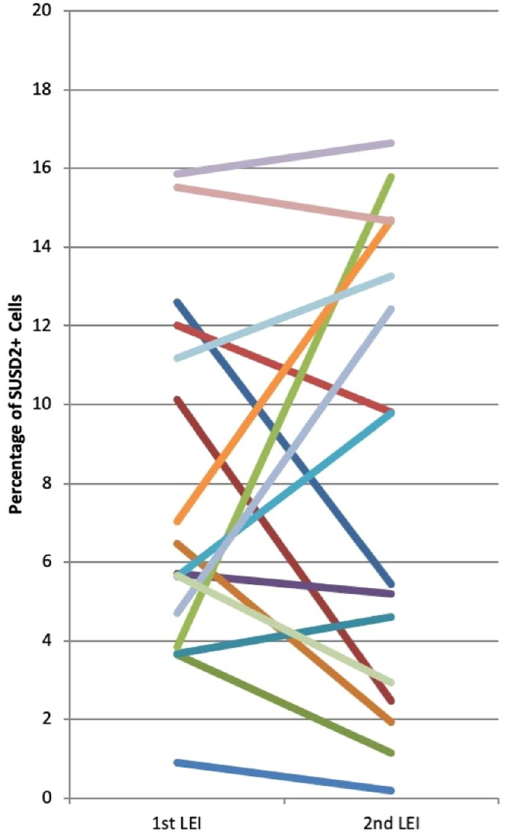
Figure 2. Percentage of SUSD2 + cells in freshly prepared stromal cell suspensions of paired samples from the first and second LEI. n =